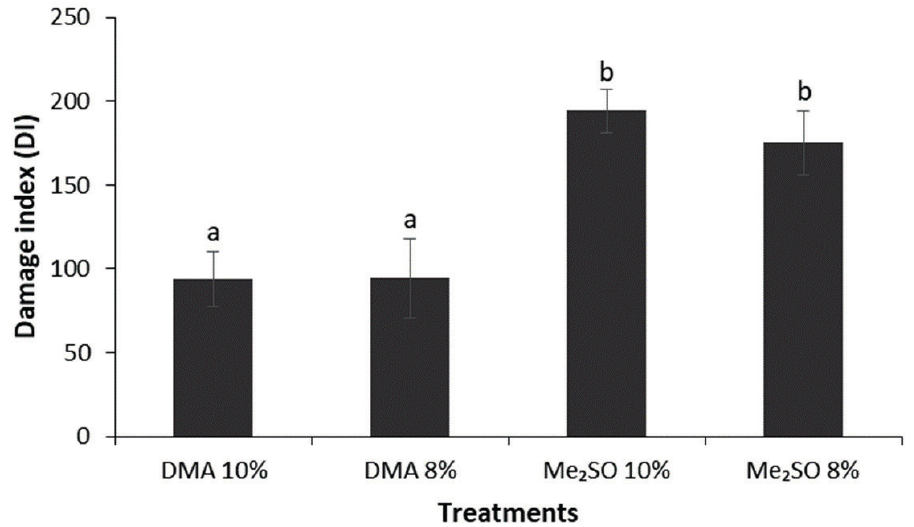
FIGURE 6 | Index of damage caused to DNA by the cryopreservation process of semen from Pseudoplatystoma corruscans . Different letters indicate significant differences (P < 0.05), by the Turkey